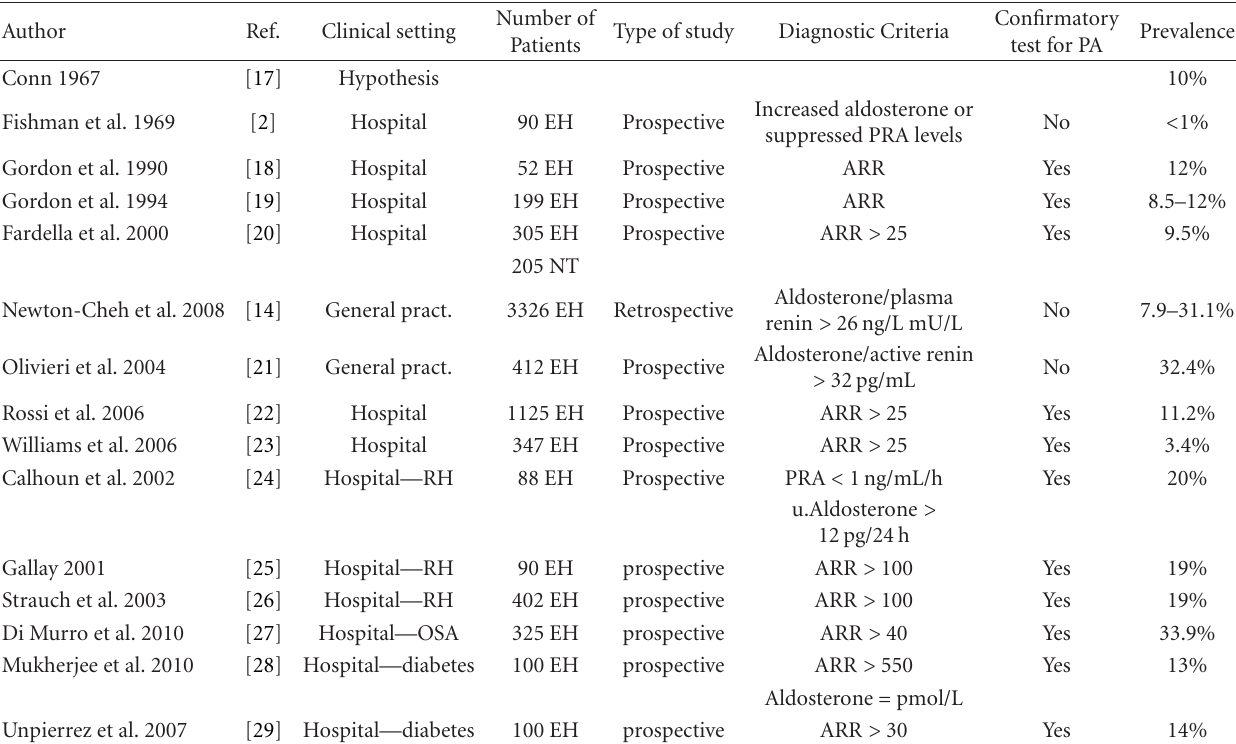
Table 2: Epidemiology study on primary